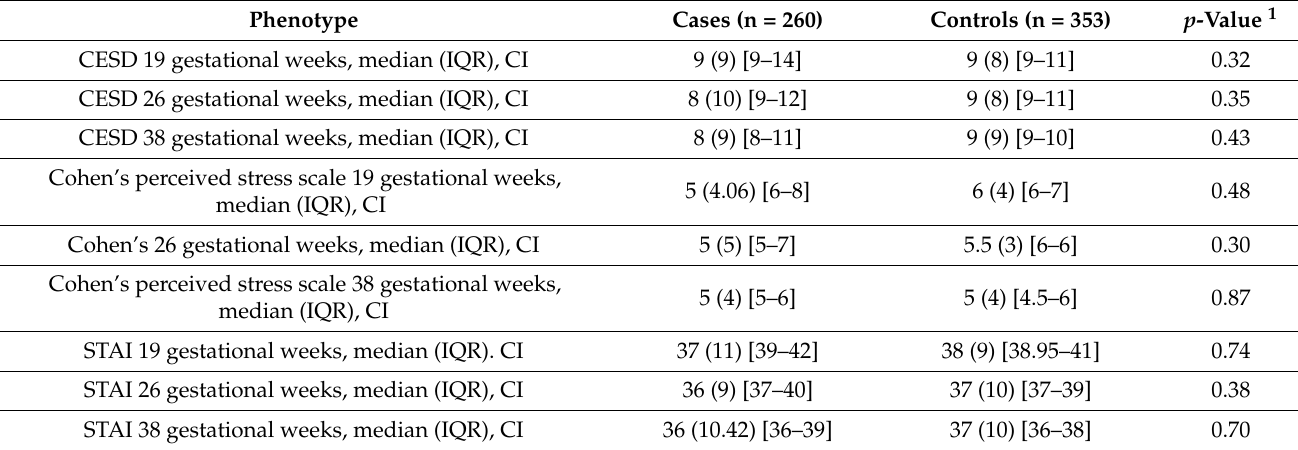
Table 2. Self-reported maternal psychological health in cases and